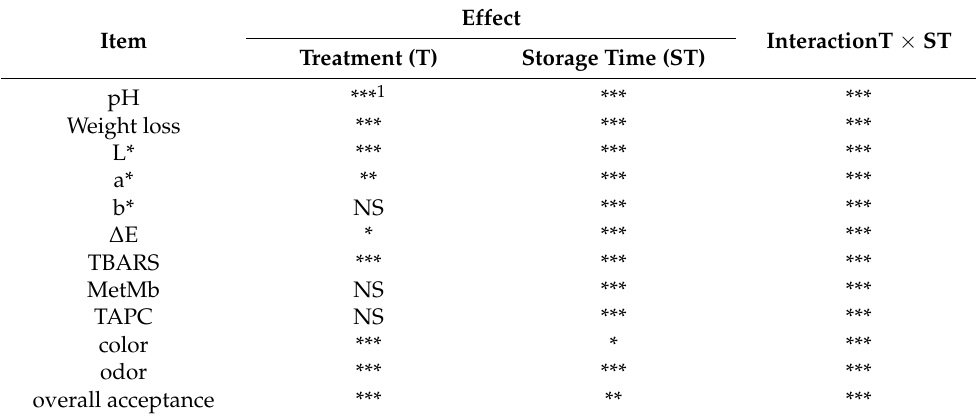
Table 1. Test probabilities for tee physical, chemical and microbiological parameters of pork loins: multiaspect variance analysis.